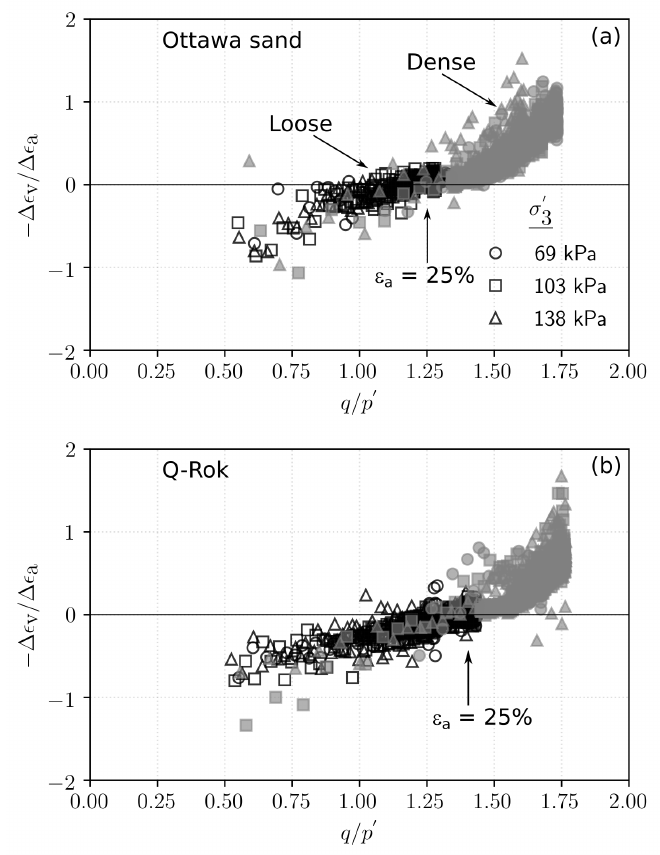
Figure 14. Stress–dilatancy plot showing the current rate of dilation for ( a ) dense and loose specimens of Ottawa sand, ( b ) dense and loose specimens of Q-Rok.